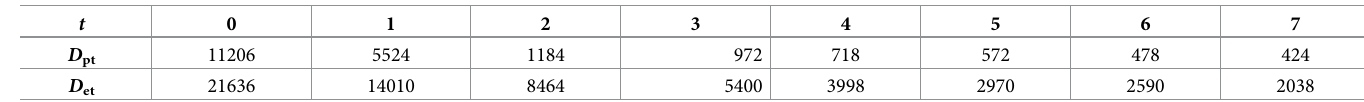
Table 2. Patient sub-dataset